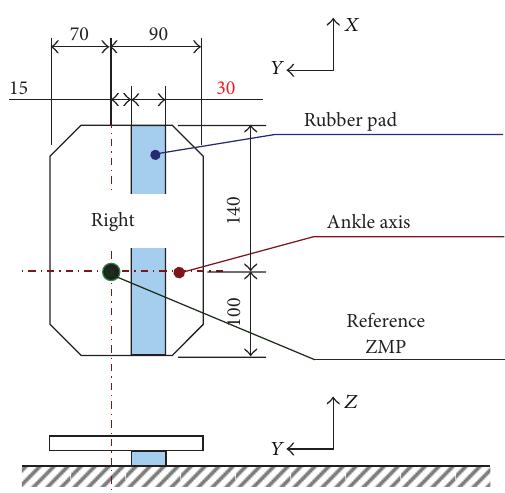
Figure 10: Narrow feet with 30 mm breadth. A rubber pad with 30 mm breadth is attached to the sole of the robot’s feet.